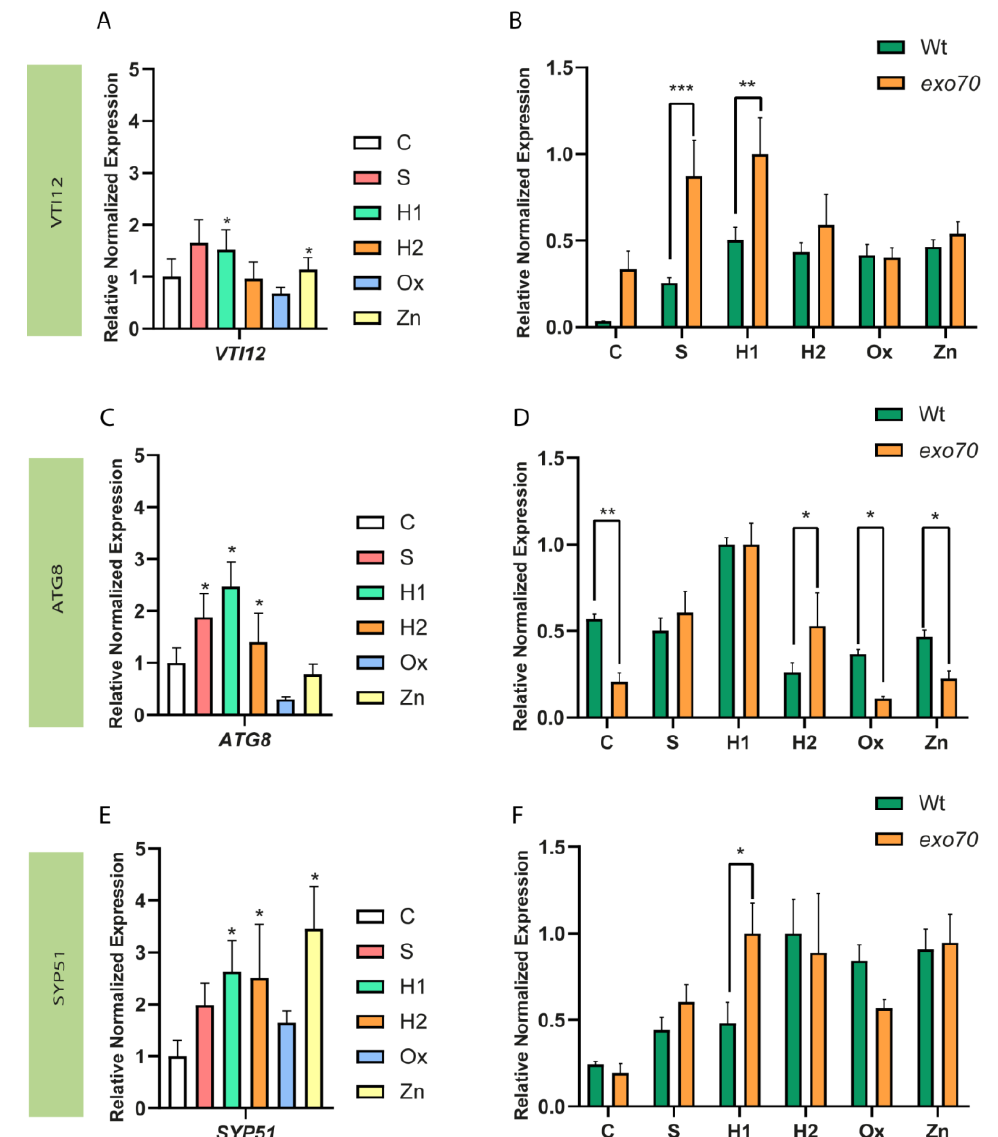
Figure 2. Expression analysis by qRT-PCR of EXPO-related genes in exo70e2 plants in control and under stress. Bar chart analysis of relative normalised expression of AtATG8 ( A , B ), AtVTI12 ( C , D ), and AtSYP51 ( E , F ), in the mutant background and under stress conditions. Analysis was performed by comparing each stress condition with the control ( A , C , E ) and by comparing each stress condition in wt and exo70e2 plants ( B , D , F ). Expression of these genes varied with the stress condition in the mutant background, and significant changes were observed when the expression was compared with that of wt, in the same stress conditions. The outcome results from the evaluation of at least three experimental replicates (n ≥ 3) are presented. * Indicates statistically experimental values ( p < 0.05), calculated using one-way ANOVA statistical tests. C — control; S — salt stress (50 mM NaCl); H1 — drought stress (50 mM mannitol); H2 — drought stress (10 mM mannitol); Ox — oxidative stress (0.5 mM hydrogen peroxide); Zn — metal poisoning stress (150 µM zinc sulphate).